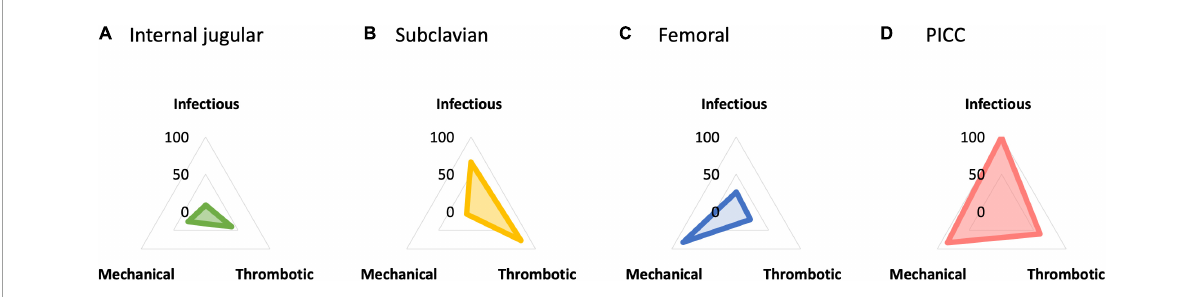
FIGURE4 (A) Internal jugular insertion. (B) Subclavian insertion. (C) Femoral insertion. (D) Peripherally inserted central venous catheter (PICC). Radar chart plot of surface under the cumulative ranking curve (SUCRA) value of each complication among central venous access sites. The SUCRA value in reducing infectious complication was higher for peripherally inserted central venous catheter (PICC) (99.5), followed by subclavian (65.9), femoral (26.2), and internal jugular insertion (8.5). For thrombotic complication, subclavian insertion showed higher SUCRA value (77.8), followed by PICC (59.8), internal jugular (40.6), and femoral insertion (21.8). For mechanical complication, PICC showed higher SUCRA value (83.8), followed by femoral (82.2), internal jugular (27.3), and subclavian insertion (6.6). PICC, peripherally inserted central venous catheter; SUCRA, surface under the cumulative ranking